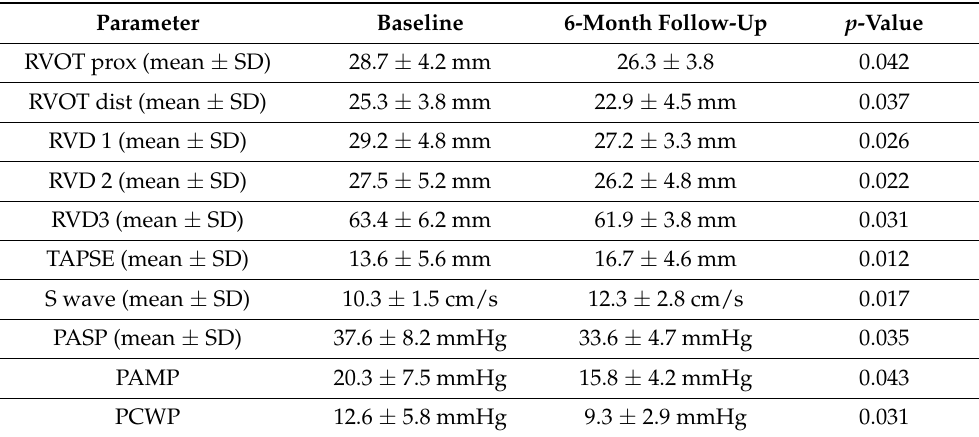
Table 2. Effects of CCM on the right ventricular dimensions, systolic function, and hemodynamic parameters at the six-month follow-up.